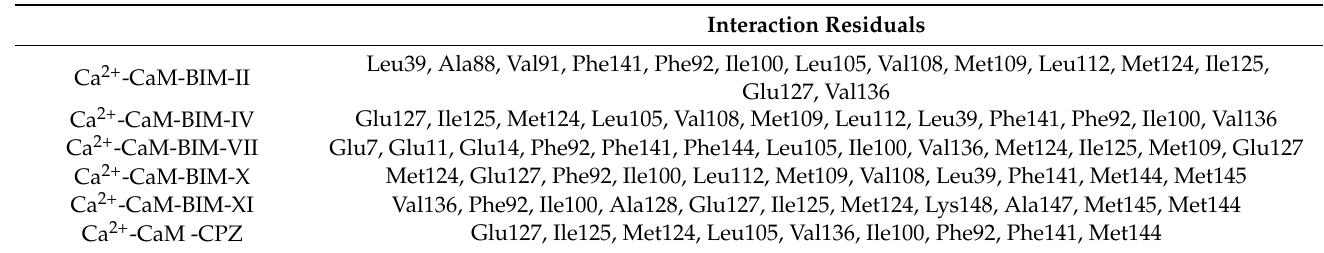
Table 3. Theoretical energy parameters of the Ca 2+ -CaM-BIM complexes from the MD studies.